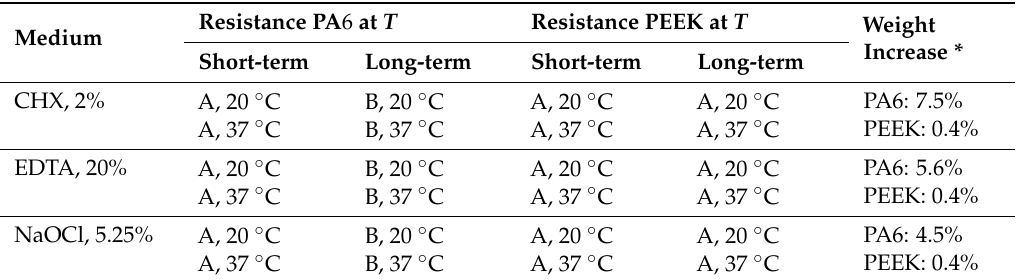
Increase * Short-term Long-term Short-term Long-term